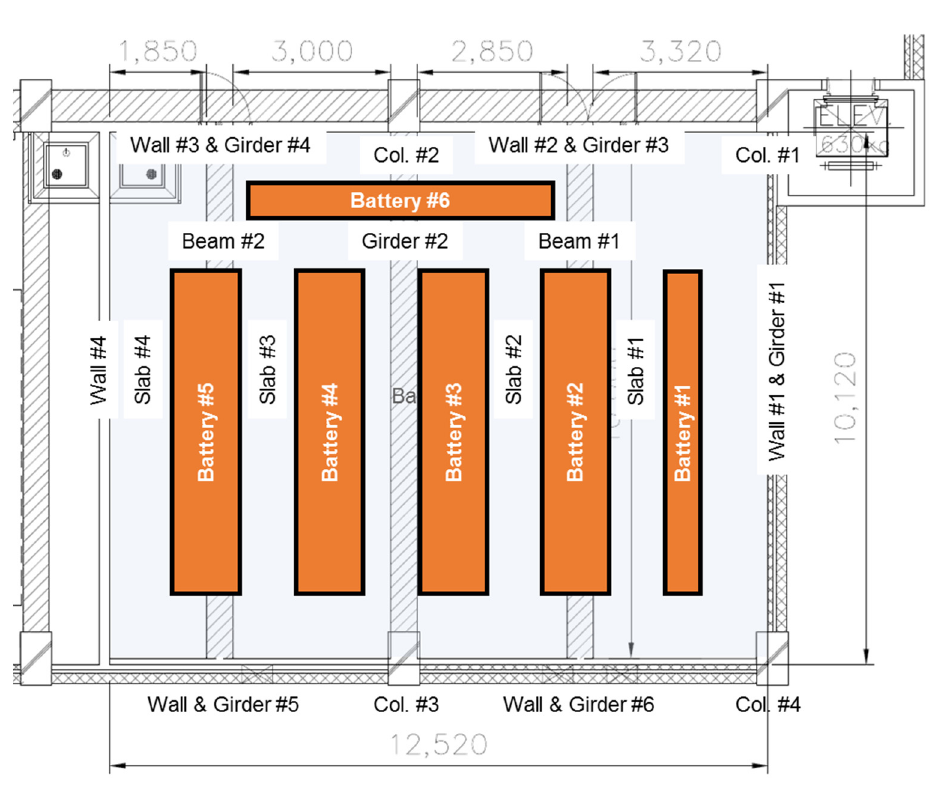
Figure 1. Locations of structural elements and batteries in the battery room.